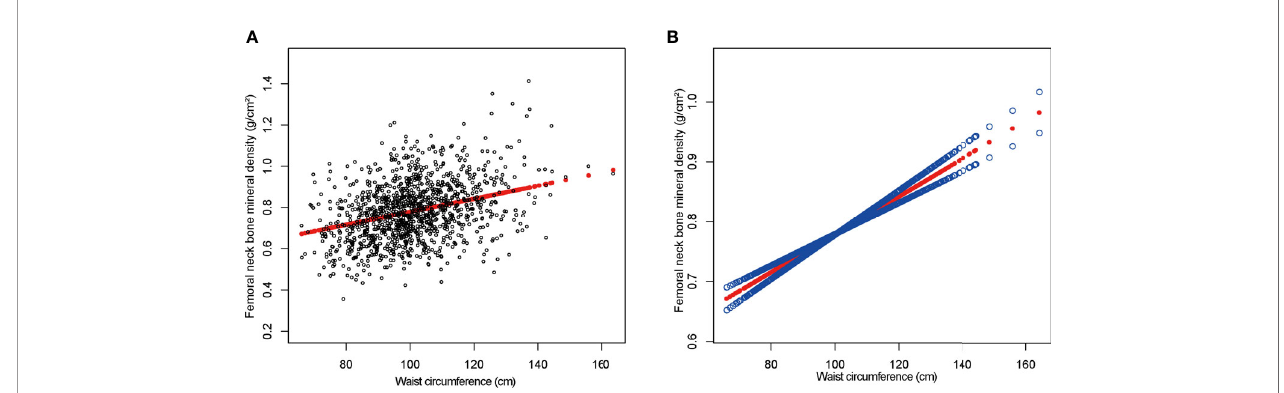
FIGURE 3 | The association between waist circumference and femoral neck bone mineral density. (A) Each black point represents a sample. (B) The solid red line represents the smooth curve fi t between variables. Blue bands represent the 95% con fi dence interval from the fi t. Age, gender, race, education level, activities status, diabetes status, NAFLD status, smoking status, ALT, ALP, AST, total calcium, total cholesterol, direct HDL cholesterol, LDL cholesterol, triglyceride, and serum phosphorus were